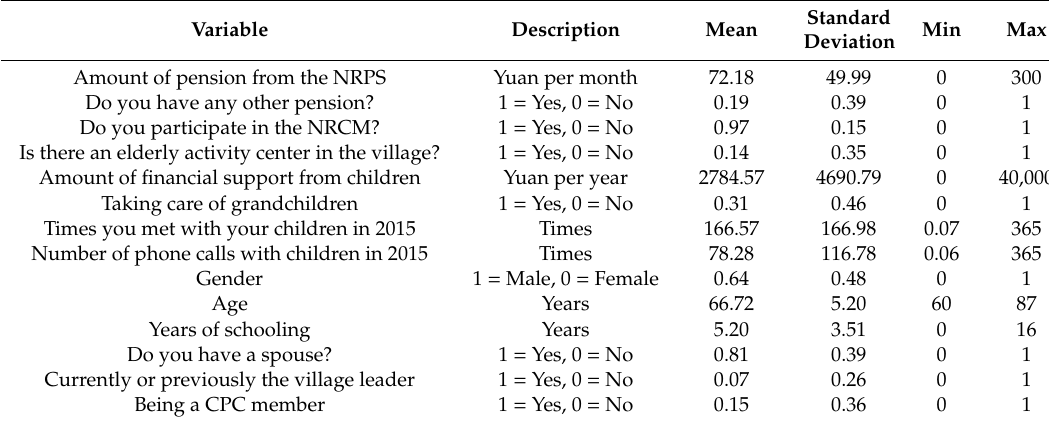
Table 1. Descriptive statistics of variables ( N =